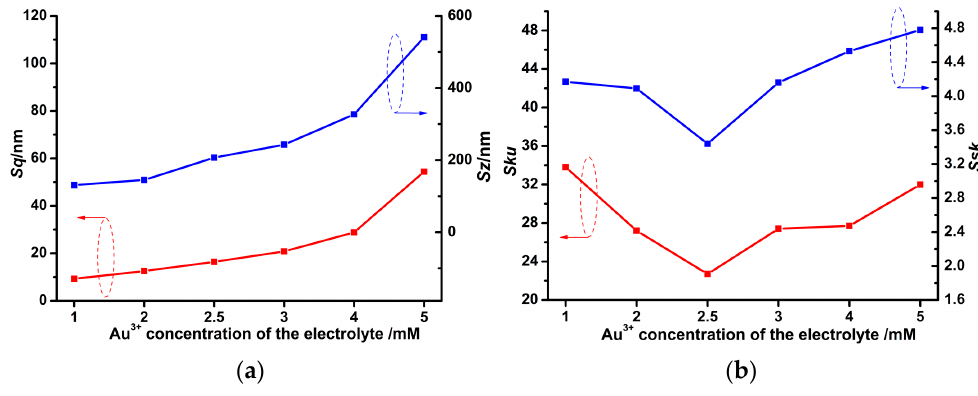
Figure 6. Effect of the Au 3+ concentration of the electrolyte on Sz and Sq ( a ), as well as Ssk and Sku ( b ), of Au solid contact layers.